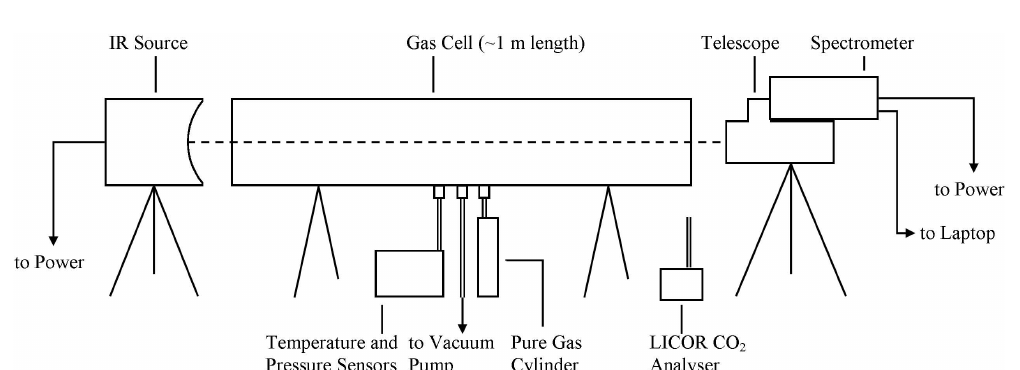
Fig. 2. Schematic of the physical instrumentation arrangement used in the current